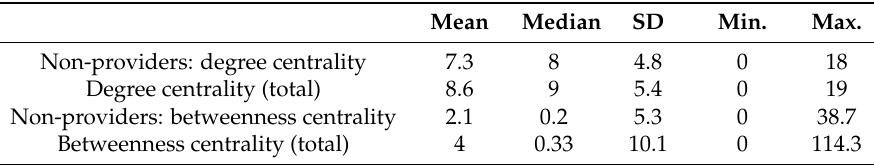
Table 3. Node degree and betweenness centrality. Total and